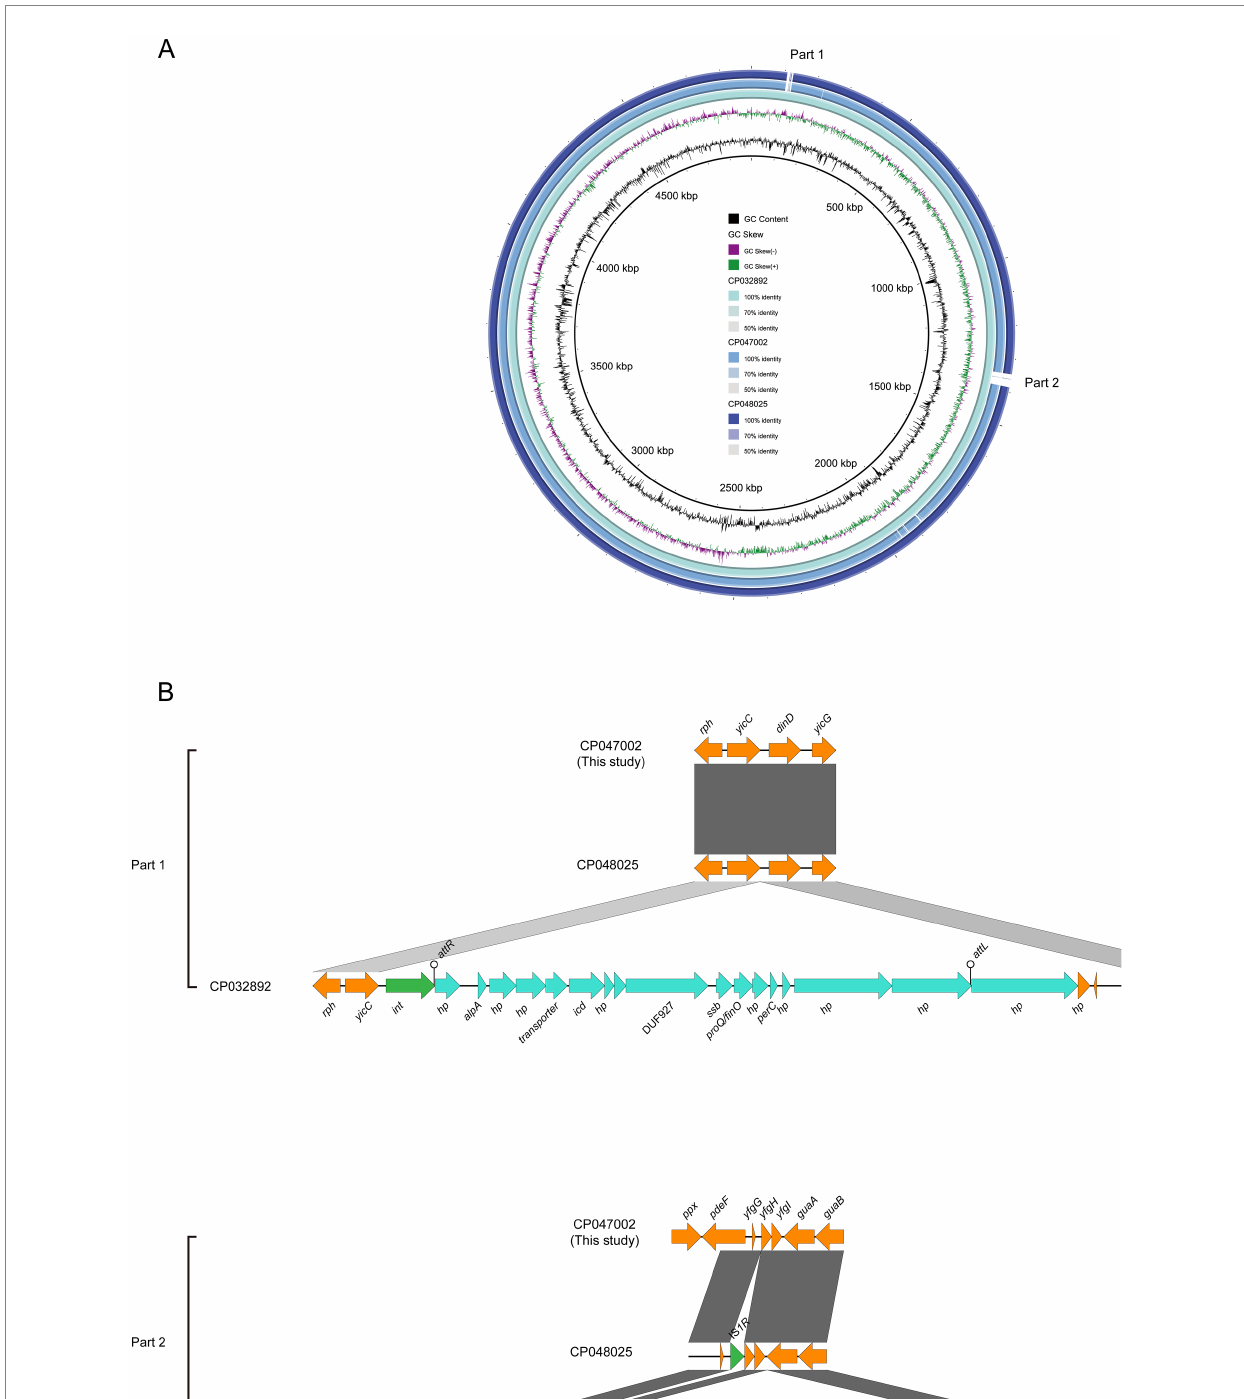
FIGURE 3 Comparative genomic analysis of mcr-1 -carrying chromosomes of ST156 J-8 (CP047002, this study) compared with those of Escherichia coli ST156 SCEC020022 (CP032892), GZEC065 (CP048025) (A) . The chromosome of E. coli SCEC020022 was used as a reference sequence in this case. Colinear sequence comparison of Part 1 and Part 2 on the chromosome SCEC020022, along with chromosomes J-8 and GZEC065. Boxed arrows represent the position and transcriptional direction of ORFs. Dark grey shading denotes regions of homology (>99% identity nucleotide identity) (B) . Orange colors represent other genes; cyan colors represent the genes coding phage protein; green colors represent the genes coding integrase ( int ) and insertion sequence